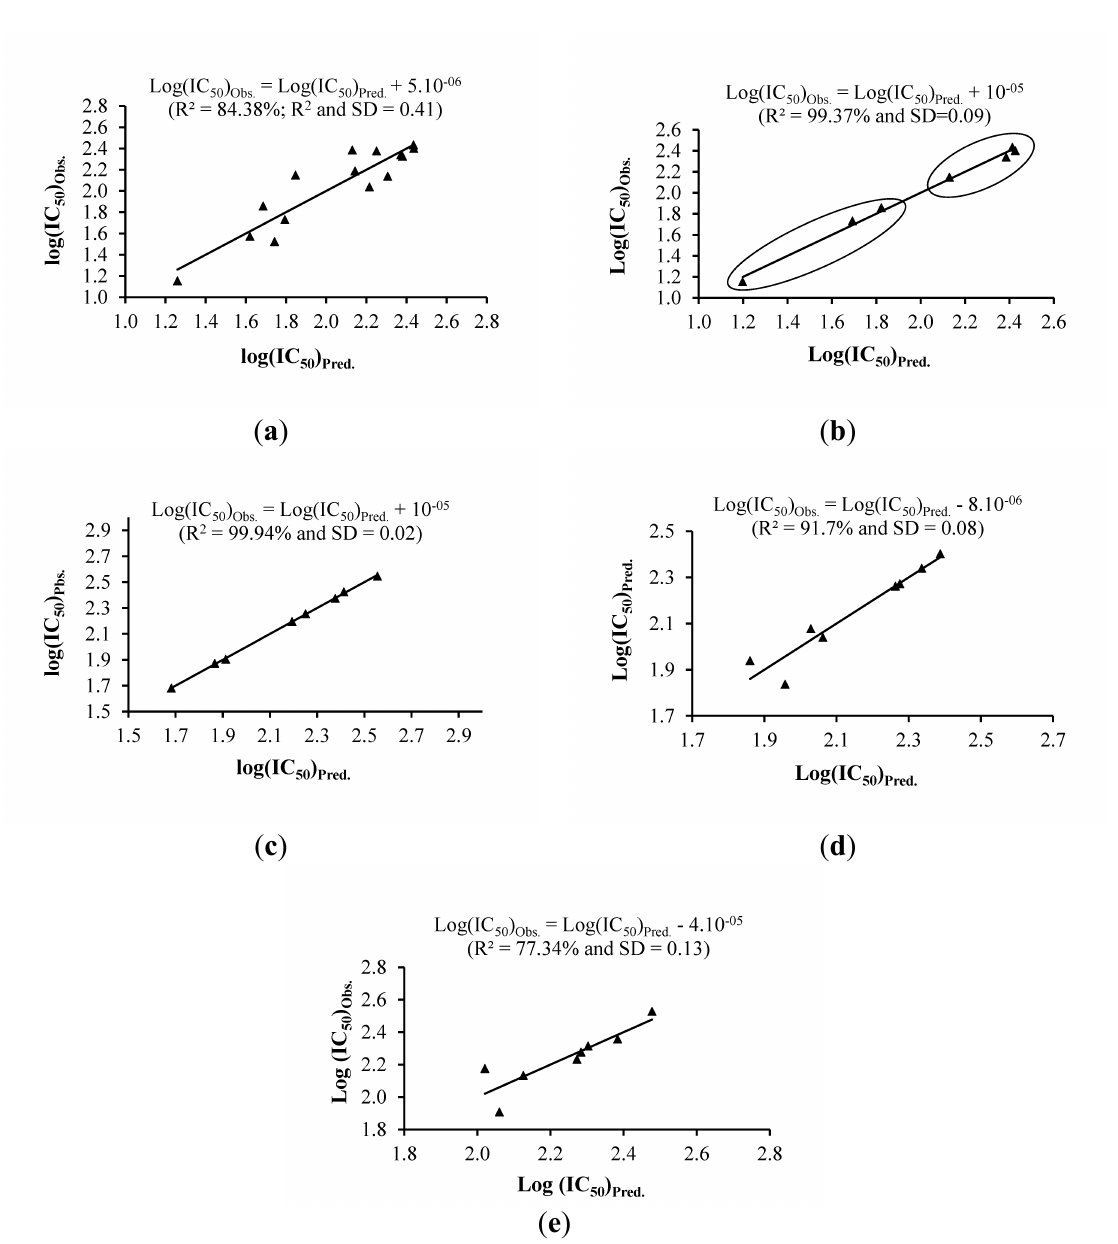
Figure 3. Multiple linear regression (MLR) correlations between most important descriptors and the cytotoxic activity of the active compounds isolated from C. zedoaria . ( a ) MLR analysis for cytotoxicity against MCF-7; ( b ) Modified MLR analysis of compounds 1 – 11 for cytotoxicity against MCF-7; ( c ) MLR analysis for cytotoxicity against Ca Ski; ( d ) MLR analysis for cytotoxicity against PC-3; ( e ) MLR analysis for cytotoxicity against